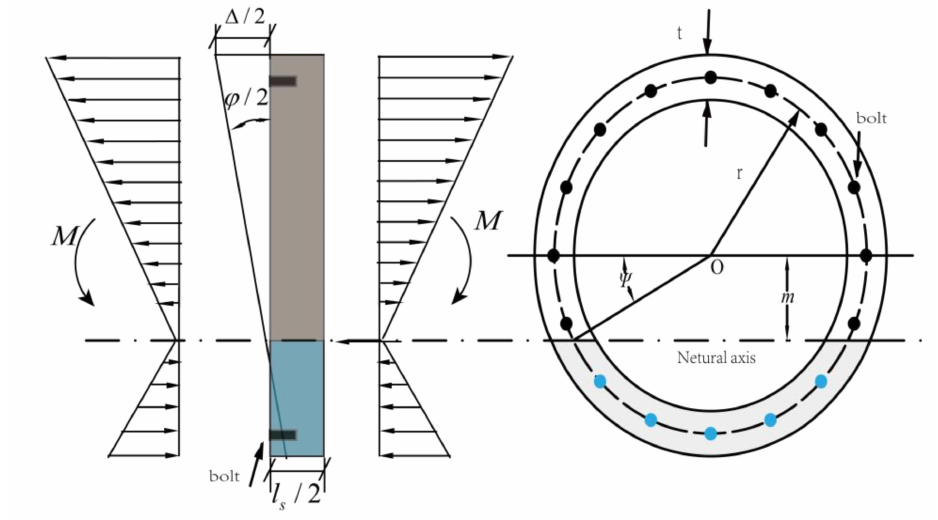
Figure 7. Deformation and force diagram of the lining